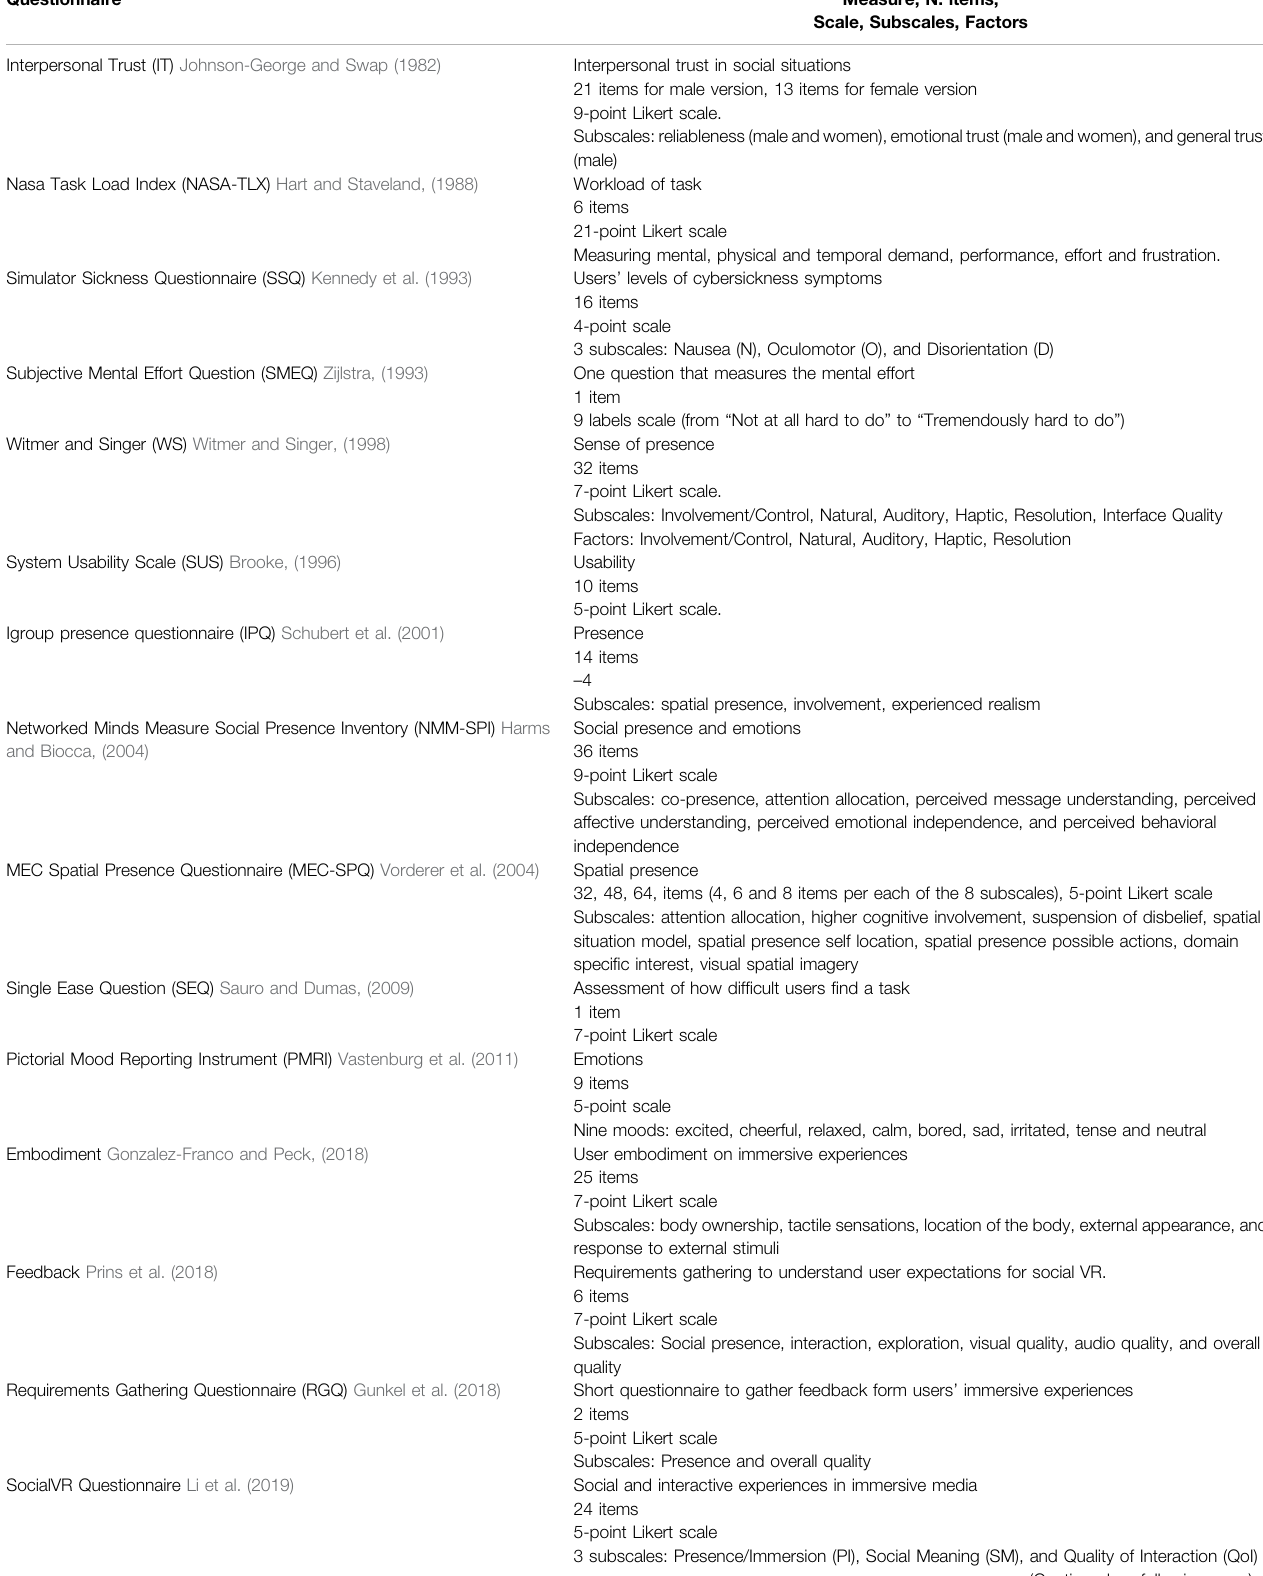
Scale, Subscales, Factors